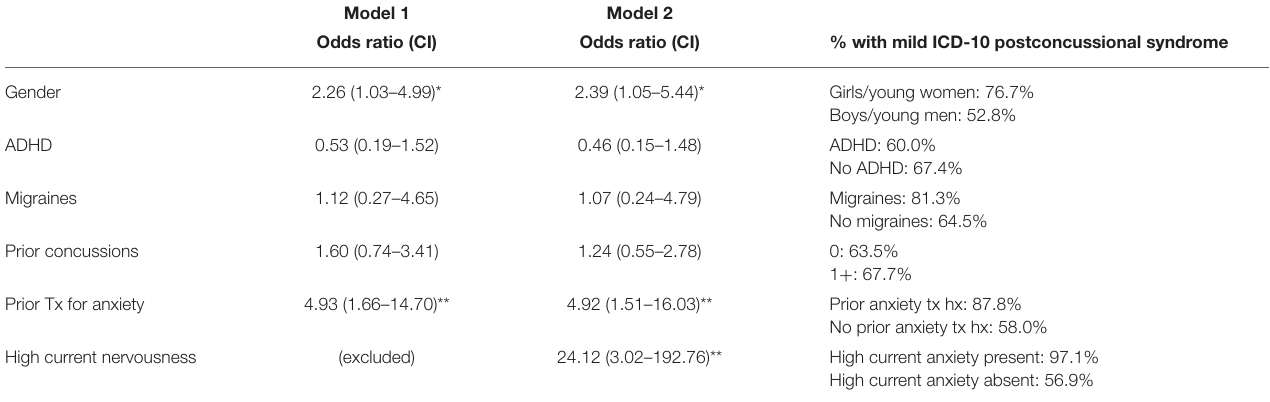
TABLE 4 | Logistic regression results and base rates of symptom reporting similar to mild ICD-10 postconcussional syndrome youth with